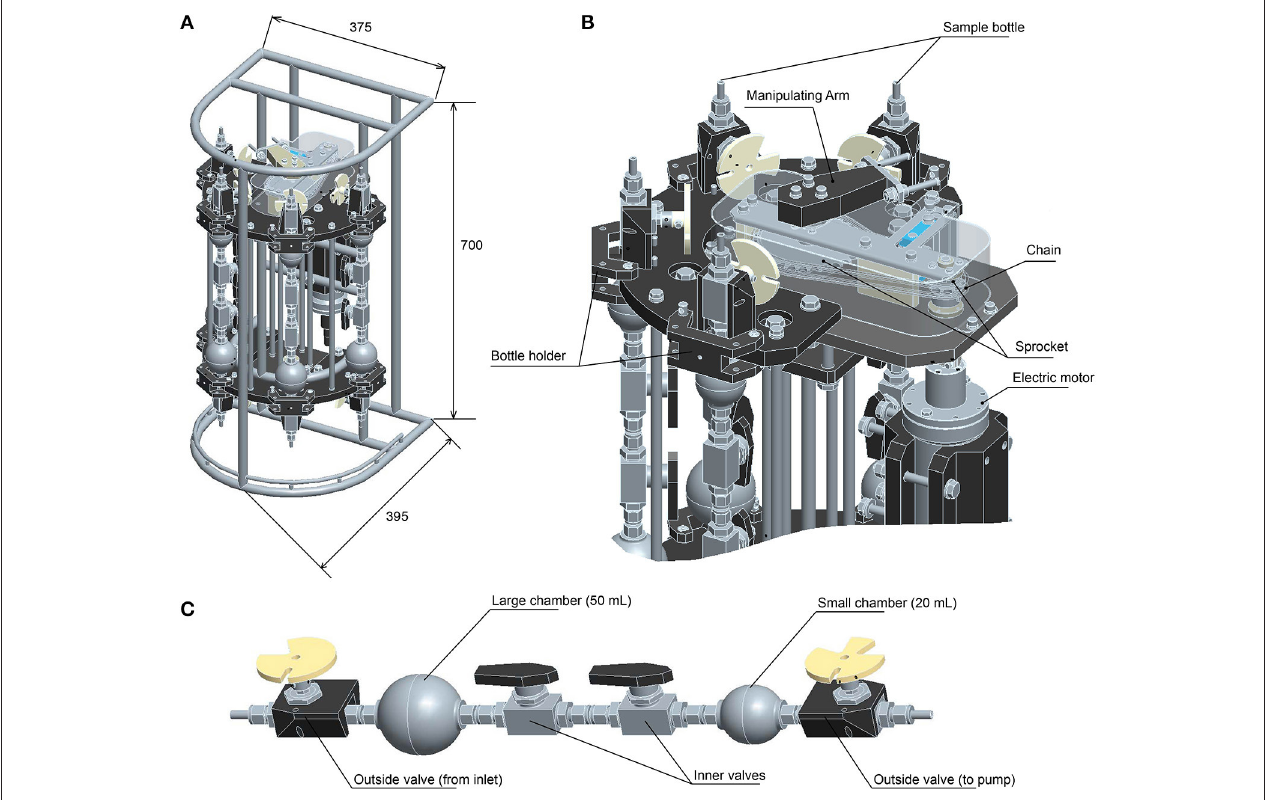
FIGURE 1 | Illustrations of the WHATS-3. (A) Dimensions (mm). (B) Valve manipulating mechanics (upper part only). (C) Sampling